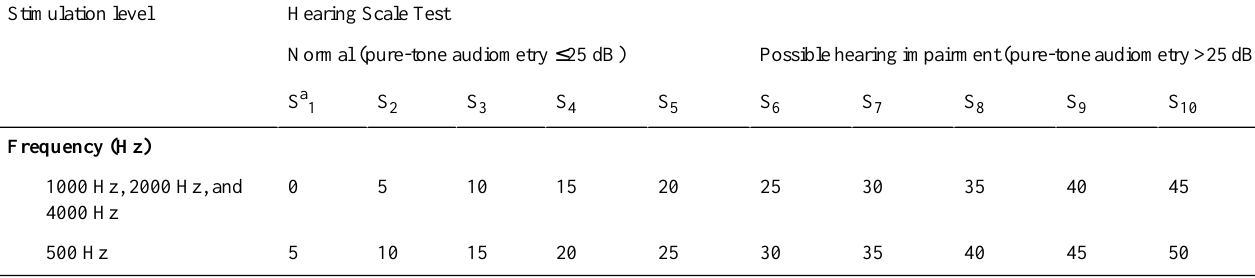
Table 1. Stimulus levels in dB hearing level for tested frequencies in the proposed Hearing Scale Test. Hearing Scale TestStimulation